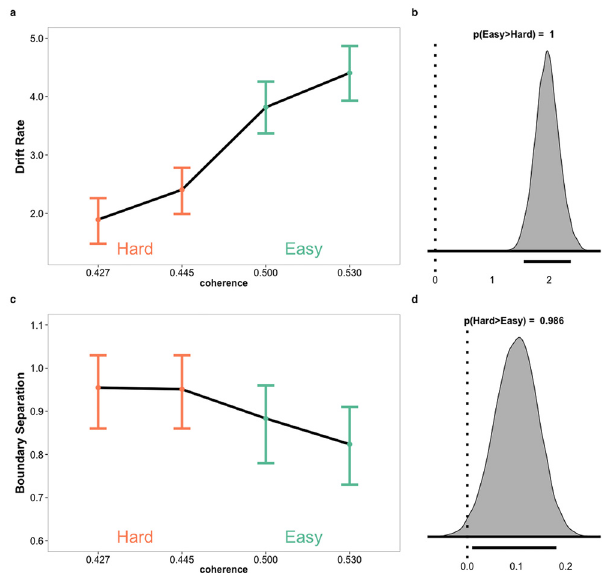
Fig 3. Posterior distributions of drift diffusion model parameters. Estimated posterior distributions for drift rate (A) and boundary separation (C) by coherence levels with error bars representing the 95% highest density intervals (HDI). Density plots for chains of difference in posterior distributions grouped to easy (green) and hard (orange) for drift rate (B) and boundary separation (D). Line below density plots represent 95% HDI of chains of difference.